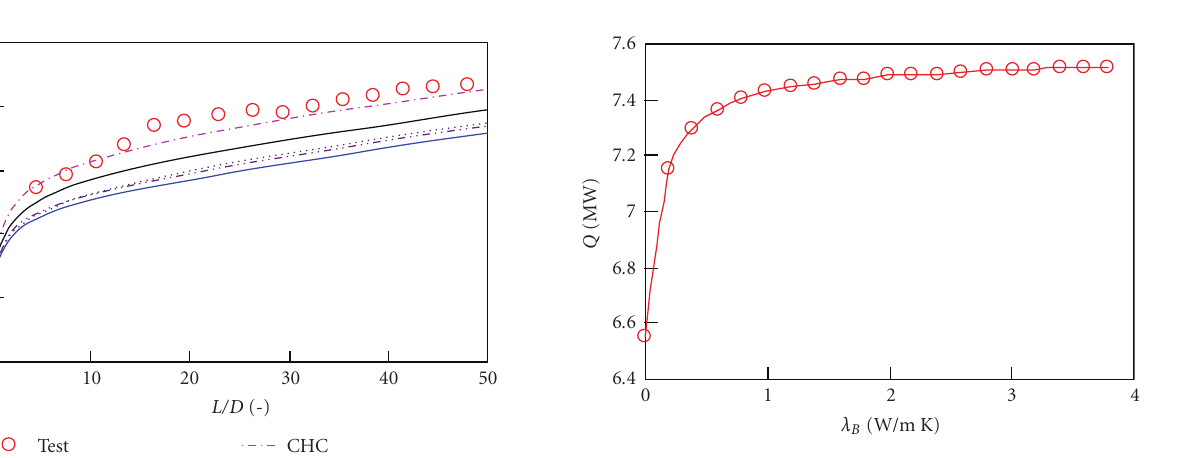
Figure 7: E ff ect of thermal conductivity of the bu ff er plate λ B on heat transfer capability Q .